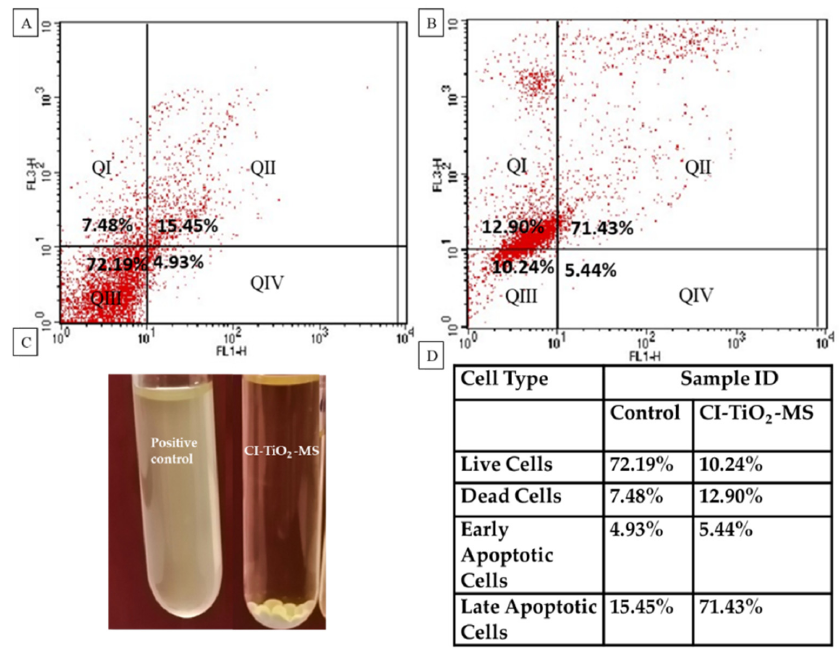
Figure 11. Flow cytometry results. ( A ) S. aureus control. ( B ) S. aureus treated by CI-TiO 2– MSs. ( C ) Samples of flow cytometry. ( D ) Table showing the percentages of lysing cells.